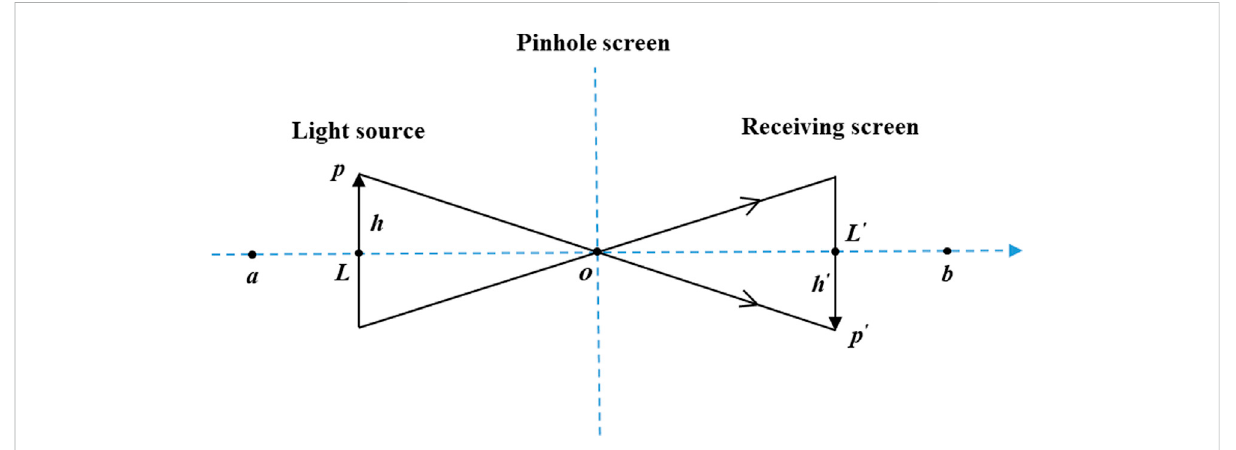
FIGURE 1 The schematic diagram of PIBL on the leading salp.